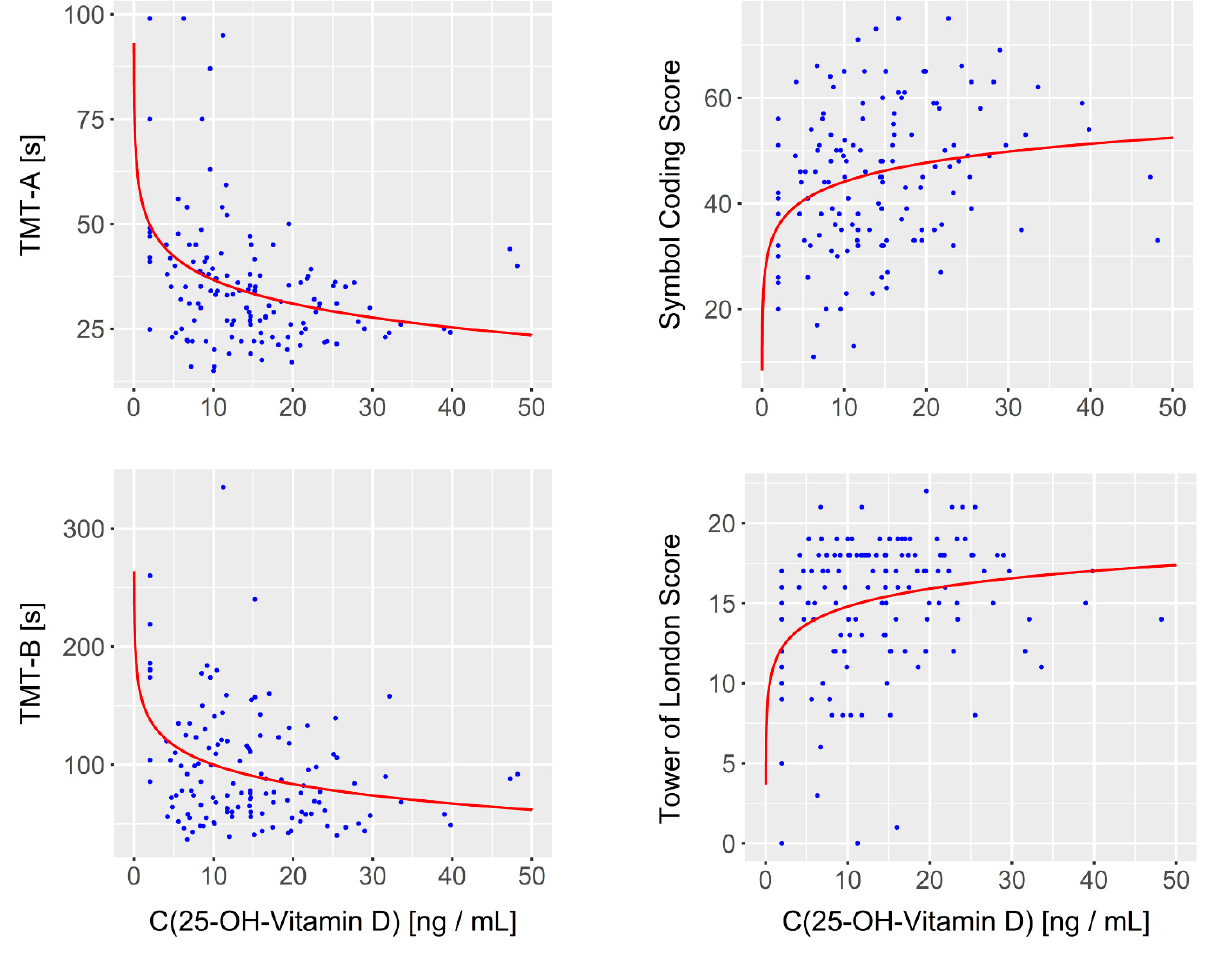
Figure 2. The relationship between 25-OH vitamin D-levels and cognition. Scatter plots and estimated regression curves are shown for the four cognitive items for which vitamin D’s impact remained statistically significant after Bonferroni correction of multiple comparisons. Curve fitting indicated that each of the different cognitive items ( y -axis) could be best described as a function of the logarithm of the 25-OH-vitamin D-concentration ( x -axis).